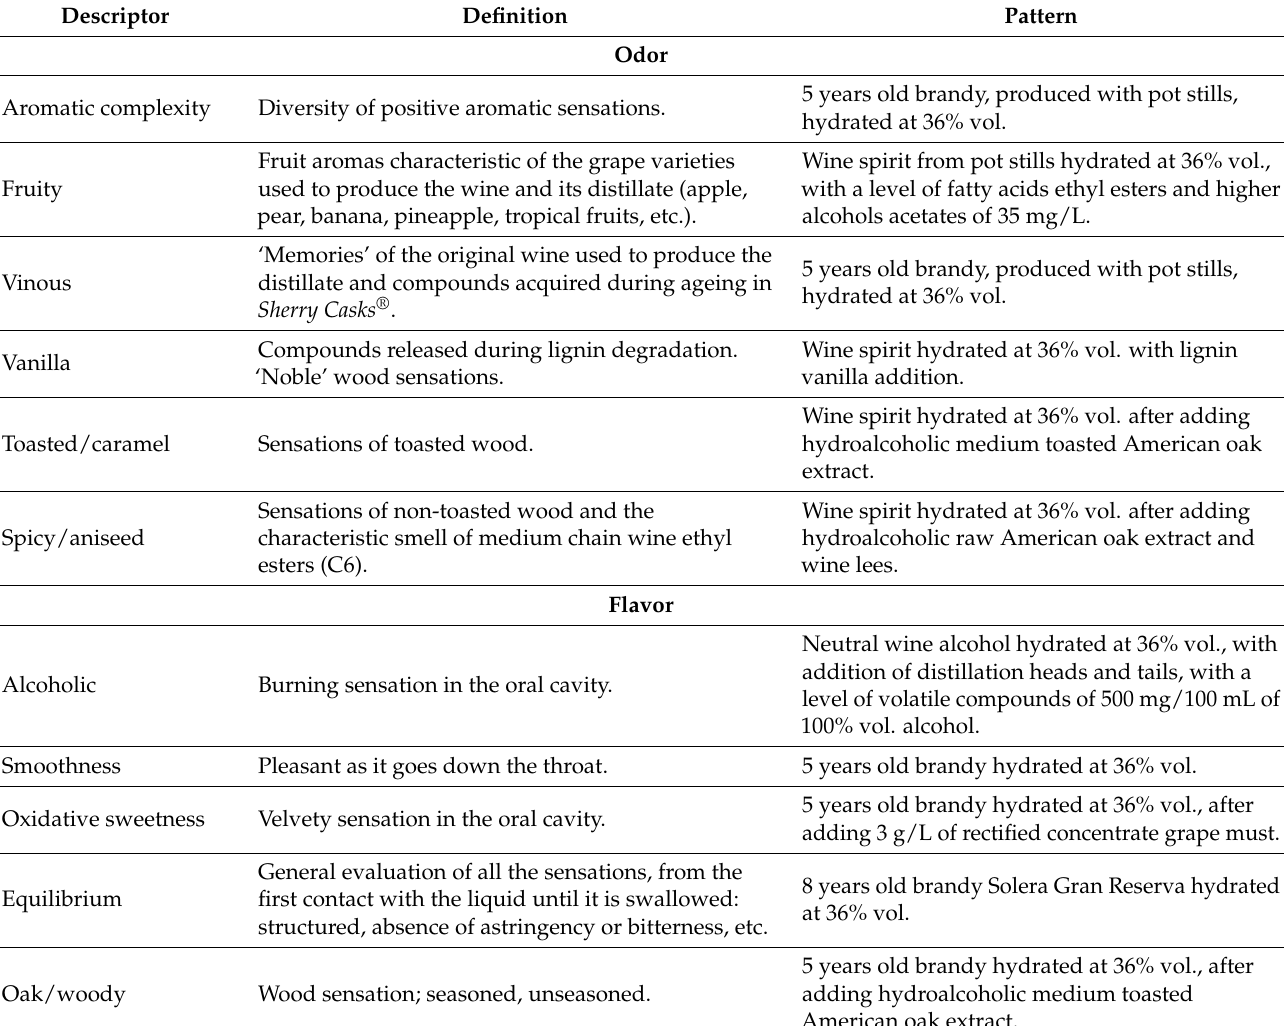
Table 2. Odor and flavor descriptors and patterns used for the training of the